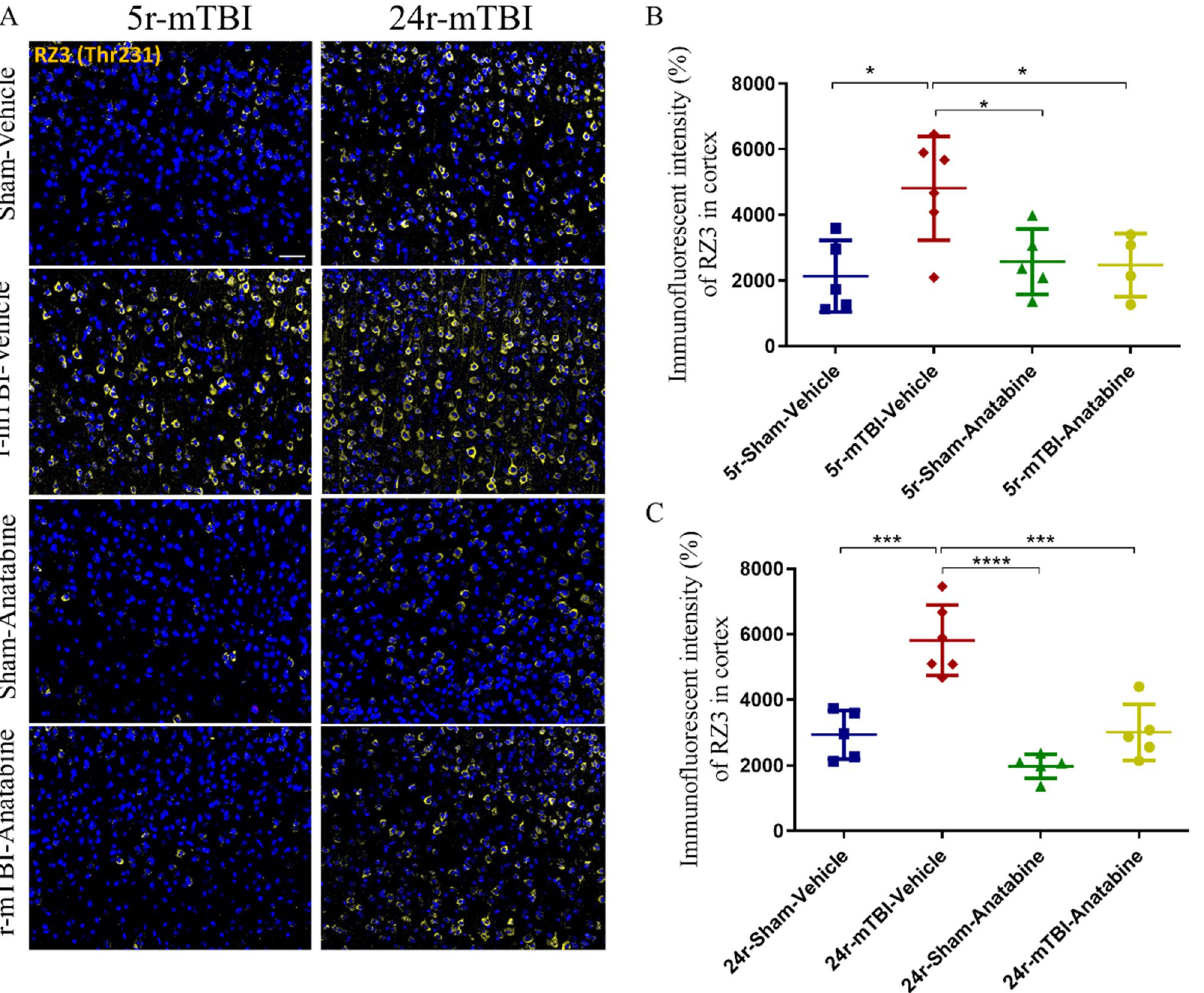
Figure 8. Evaluation of the effect of anatabine on RZ3 (Thr231) in cortex. ( A ) Representative images of RZ3 (Thr231) in cortex. TBI induced an increase of RZ3 (Thr231) in both 5r-mTBI (( B ), p < 0.05) and 24r-mTBI (( C ), p < 0.001) mice compared to the respective sham-vehicle. In anatabine treated mice, RZ3 (Thr231) was decreased in both 5r-mTBI (p < 0.05) and 24r-mTBI (p < 0.001) mice compared to the respective r-mTBI-vehicle. Data analyzed using two-way ANOVA. Scale bars equal 20